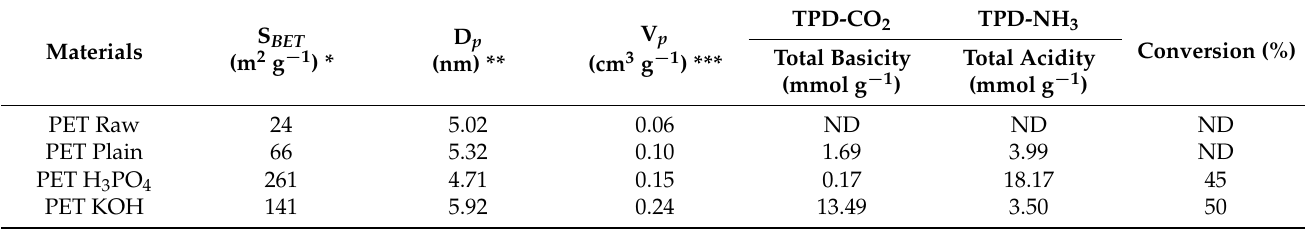
Table 1. Textural properties and total desorption of CO 2 and NH 3 for PET Raw, PET Plain, PET H 3 PO 4 and PET KOH.